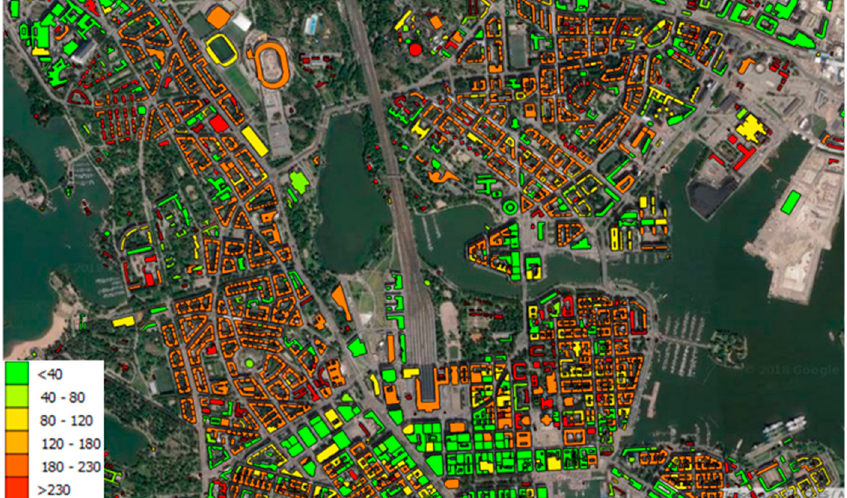
Figure 2. Modelling results for the heating demand (kWh/m 2 year) of the buildings of